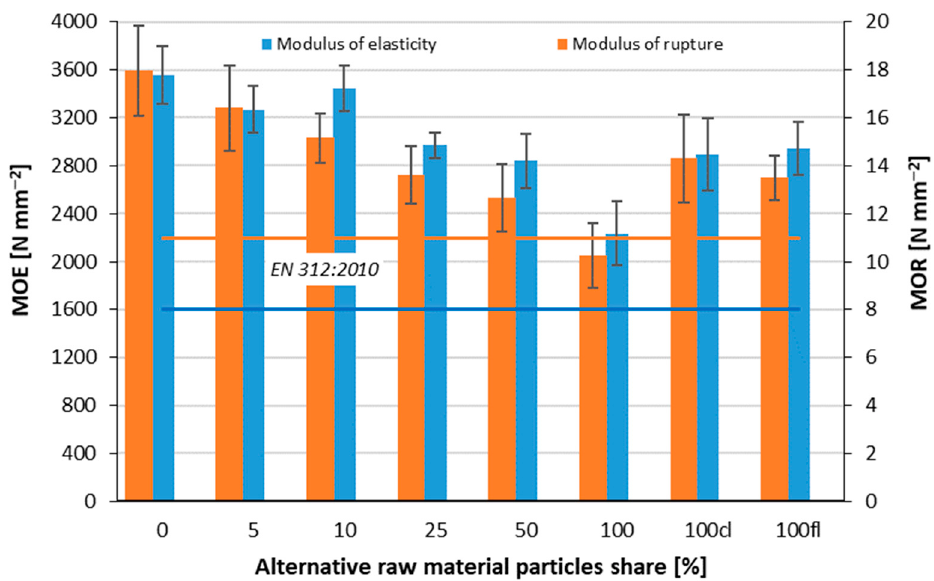
Figure 5. Modulus of rupture and modulus of elasticity of tested composites.